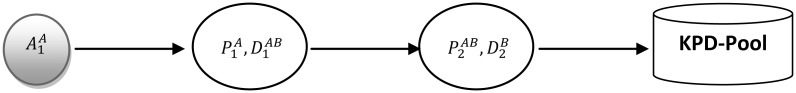
A NEAD exchange graph.A chain starts with an altruistic donor and ends with a bridge donor assigned to the first compatible patient on the next round.